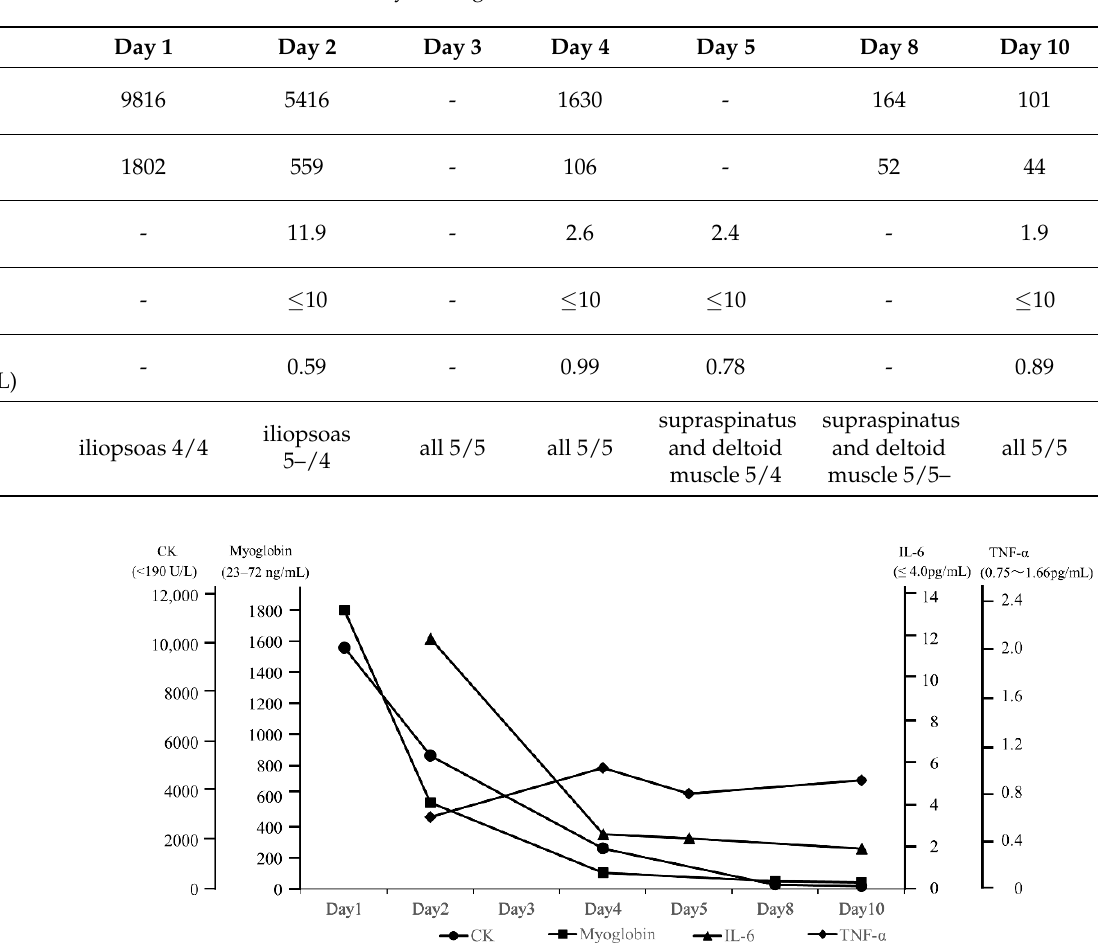
Table 1. Course of laboratory findings and MRC scale.